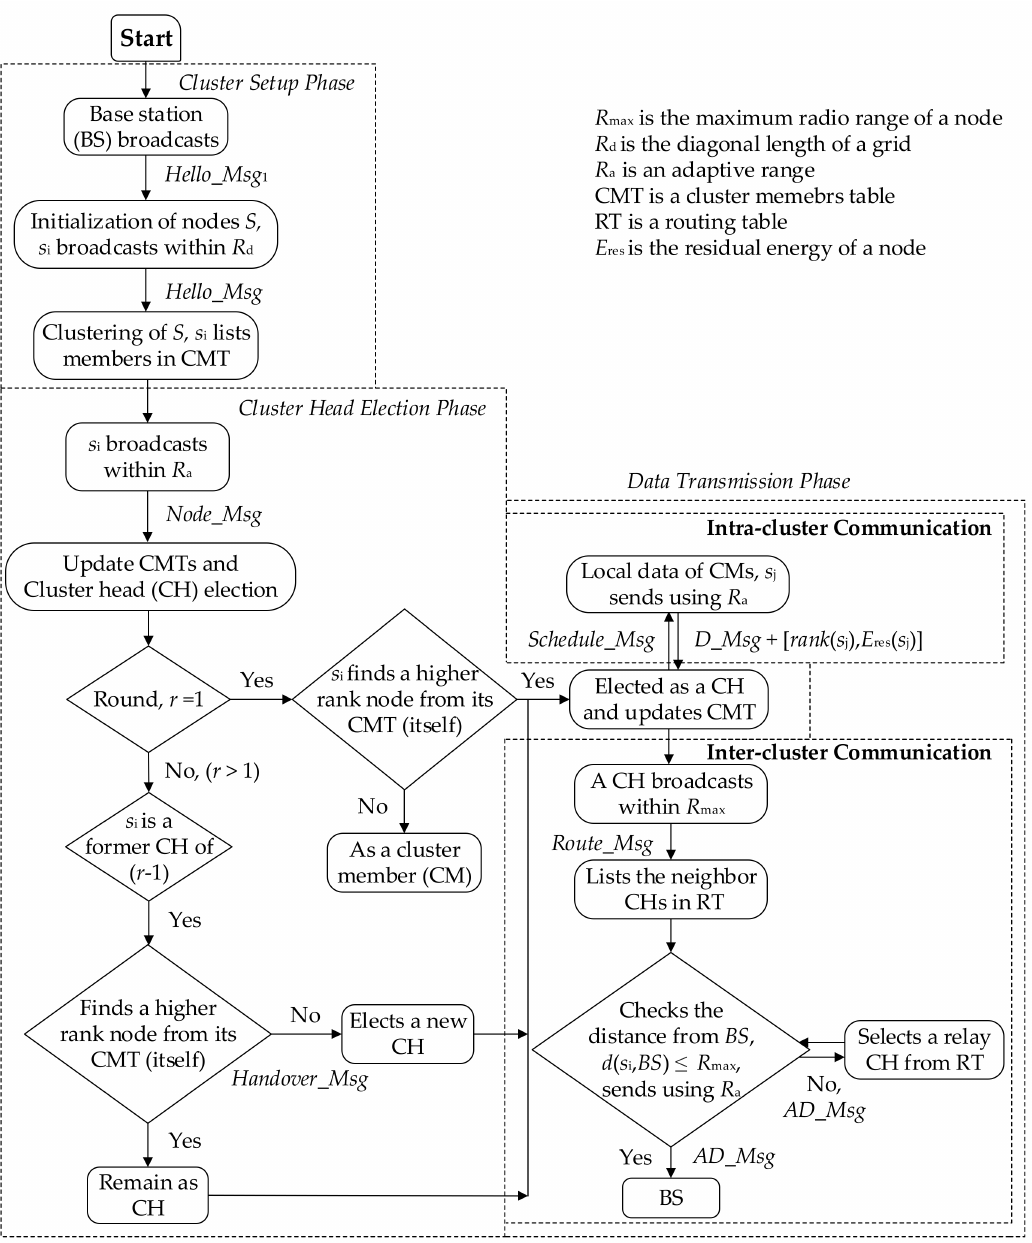
Figure 1. Flowchart of energy-centric cluster-based routing (ECCR) operation, including cluster setup, cluster-head election and data